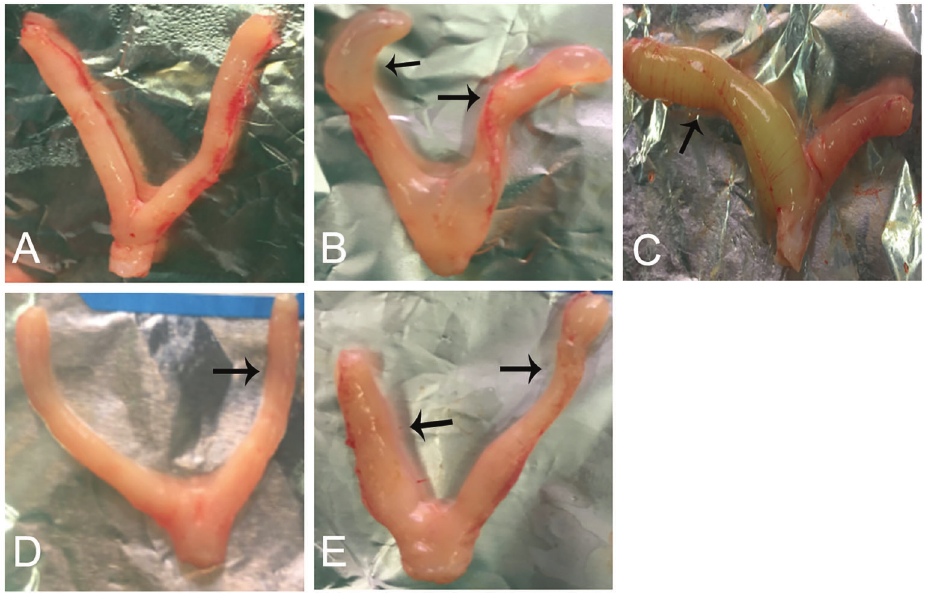
Figure 1. Macroscopic changes of uterus. The uteruses in NCG ( A ) and QSABSG (D) had uniform texture, bright color, symmetrical Y shape and did not show cysts, tubercle or tumefaction. Many uteruses in STMG (B), LTMG ( C ), and CDWSG ( E ) had cysts, nodules, and swelling (arrows). NCG: normal control group; STMG: short-term model group; LTMG: long-term model group; QSABSG: Qi stagnation and blood stasis group; CDWSG: combining disease with syndrome